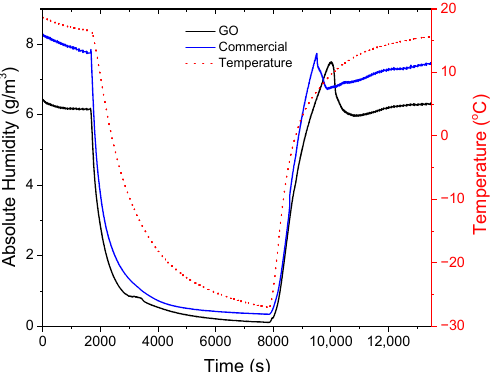
Figure 6. The response of the LIG/GO sensor and the commercial one in a cooling and heating cycle inside a specific saturated aqueous solution of Mg(NO 3 ) 2 , which provides 53% RH at 25 °C. Nanomaterials 2022 , 12 , x FOR PEER REVIEW Finally, the integration of the GO/LIG relative humidity sensor with a battery-less near-field communication (NFC) device was performed to demonstrate fast interrogation of the sensor using a smartphone. The developed sensor was connected to a capacitance- to-digital converter (CDC), which was interfaced with a microcontroller unit (MCU) using the Inter-Integrated Circuit (I2C) protocol, as shown in Figure 7a,b. An NFC Type-5-ena- bled smartphone was used to wirelessly power the humidity sensor, as shown in Figure 7c. The NFC sensor system comprised an NFC loop antenna, with the smartphone provid- ing wireless power to the sensor via inductive coupling. The NFC sensor transponder also included a Radio Frequency to Direct Current (RF-DC) converter within the NFC radio transceiver, which provided a harvested unregulated DC voltage. The harvested DC volt- age was then regulated using a low dropout voltage regulator (STLQ015M21R) that pro- vided a regulated 2.1 V DC voltage. The regulated voltage was used to power the CDC, MCU, and NFC radio transceiver. On power-up, the ambient relative humidity was sensed using the developed LIG-electrode-based humidity sensor. The sensor’s change of